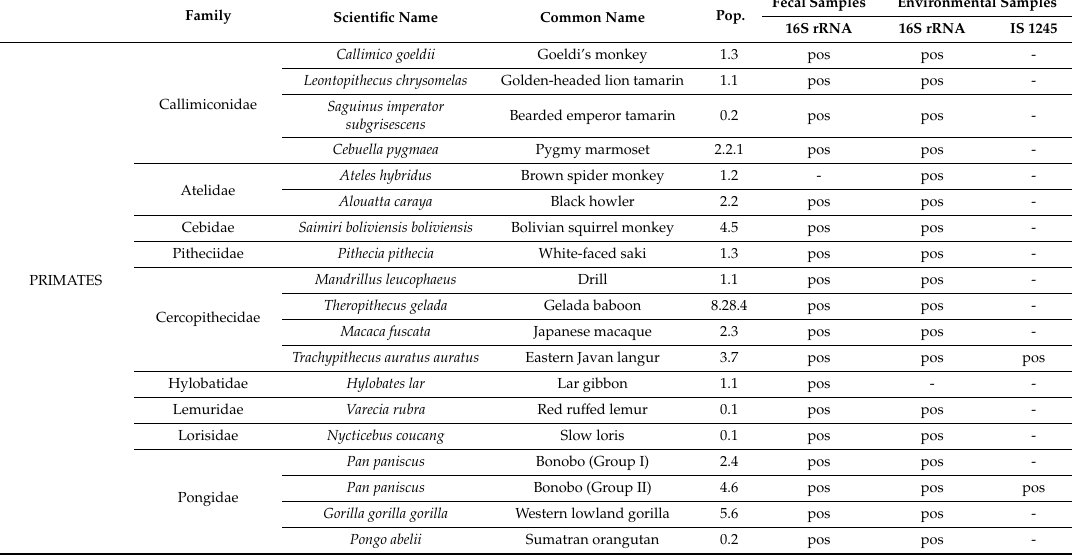
Table 2. Real-time PCR (MAC / 16S rRNA, MAH / IS1245) results of collected fecal samples and environmental